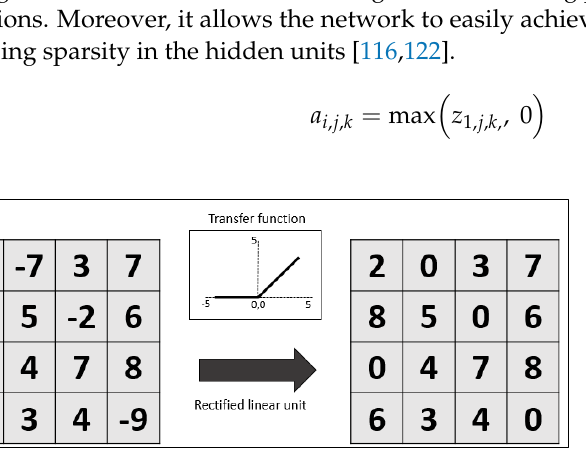
( b ) Figure 9. Example of pooling operation: ( a ) maximum pooling, ( b ) average pooling. 3.4. Fully Connected Layer The fully connected layer is the final layer after the convolutional and the pooling layers. Here, the data are transformed to a one-dimensional layer and each neuron is con- nected directly to a neuron in the previous layer. The structure for this layer may consist of one or more hidden layers. The softmax activation function is usually applied in a fully